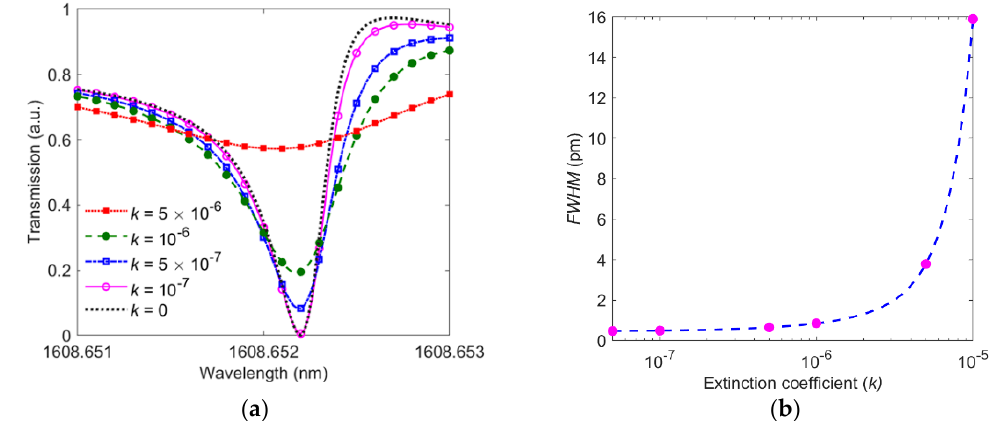
Figure 4. ( a ) Resonance relevant to the quasi-BIC mode for several values of k . ( b ) FWHW of the quasi-BIC mode vs. k .